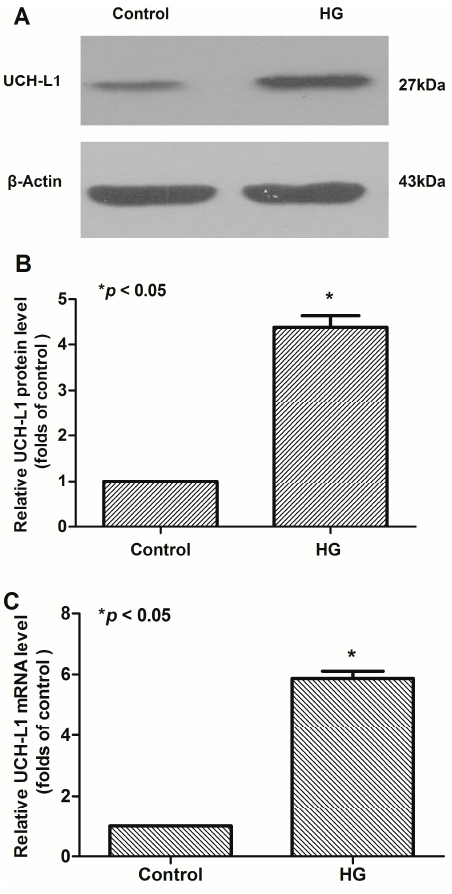
Figure 1. UCH-L1 expression induced by high glucose in podocytes. Podocytes were maintained or not in high glucose (30 mM) for 48 h. Podocyte lysate proteins (60 μ g) were analyzed respectively by western blot using murine anti-UCH-L1 antibody and β -Actin was used as control for protein loading. ( A ) Western blot assay of UCH-L1; ( B ) corresponding statistic histogram of UCH-L1 protein expression; ( C ) quantitative real-time RT-PCR assay of UCH-L1 mRNA. Data representative of three independent experiments. * p < 0.05 compared to control group.